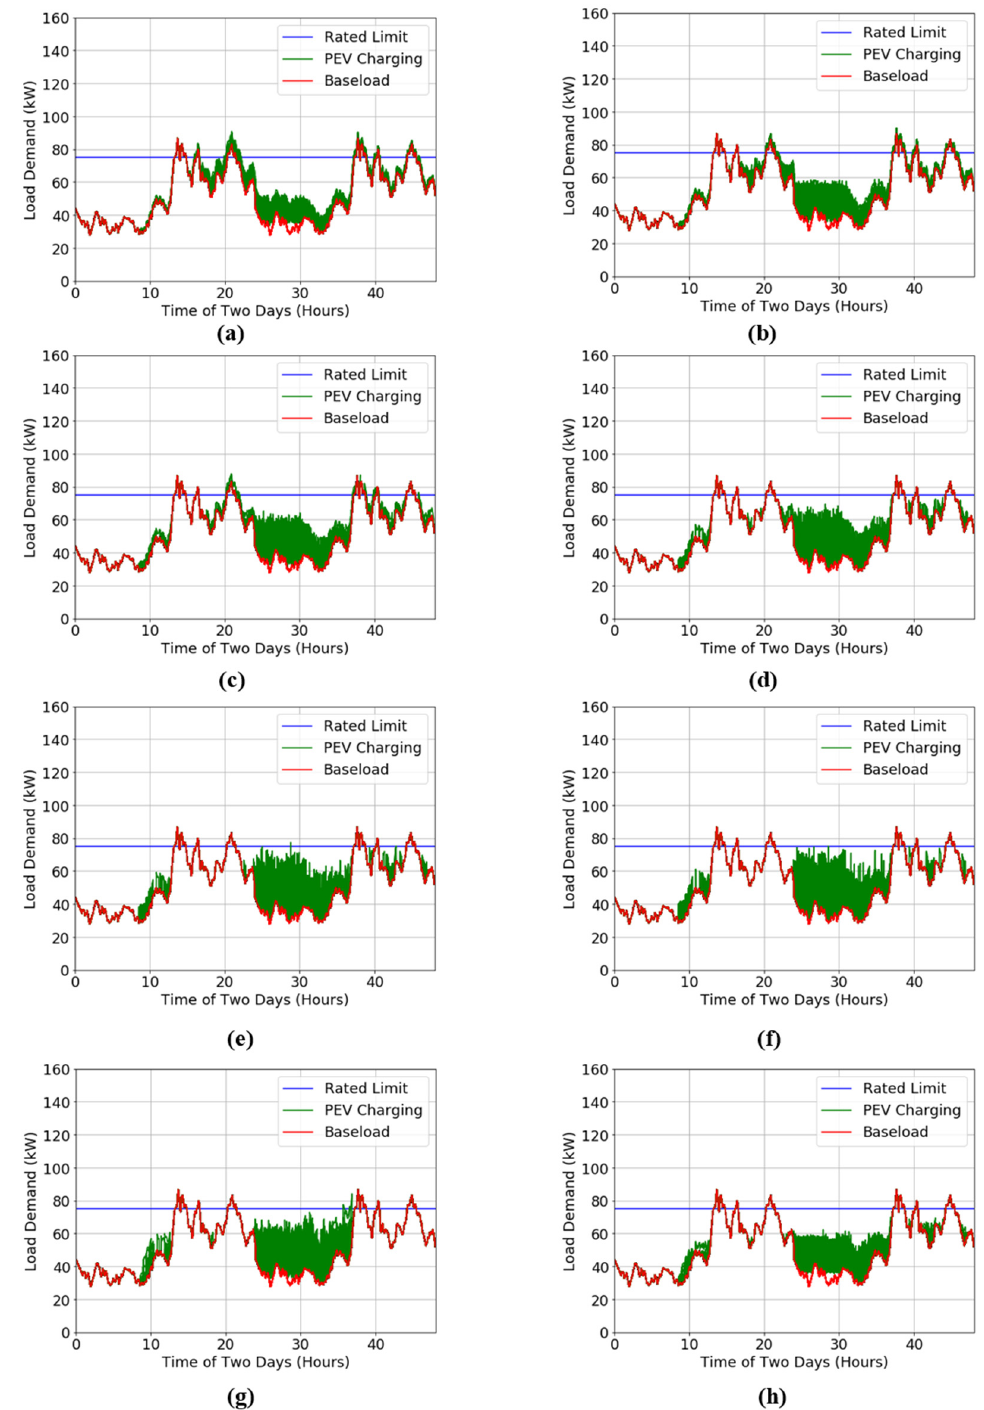
Figure 7. Charging profiles created from ( a ) 1.9 kW, ( b ) 3.3 kW, ( c ) 4.8 kW, ( d ) 7.2 kW, ( e ) 9.6 kW, ( f ) 11.5 kW, and ( g ) SRVF and ( h ) RIVF controlled charging.